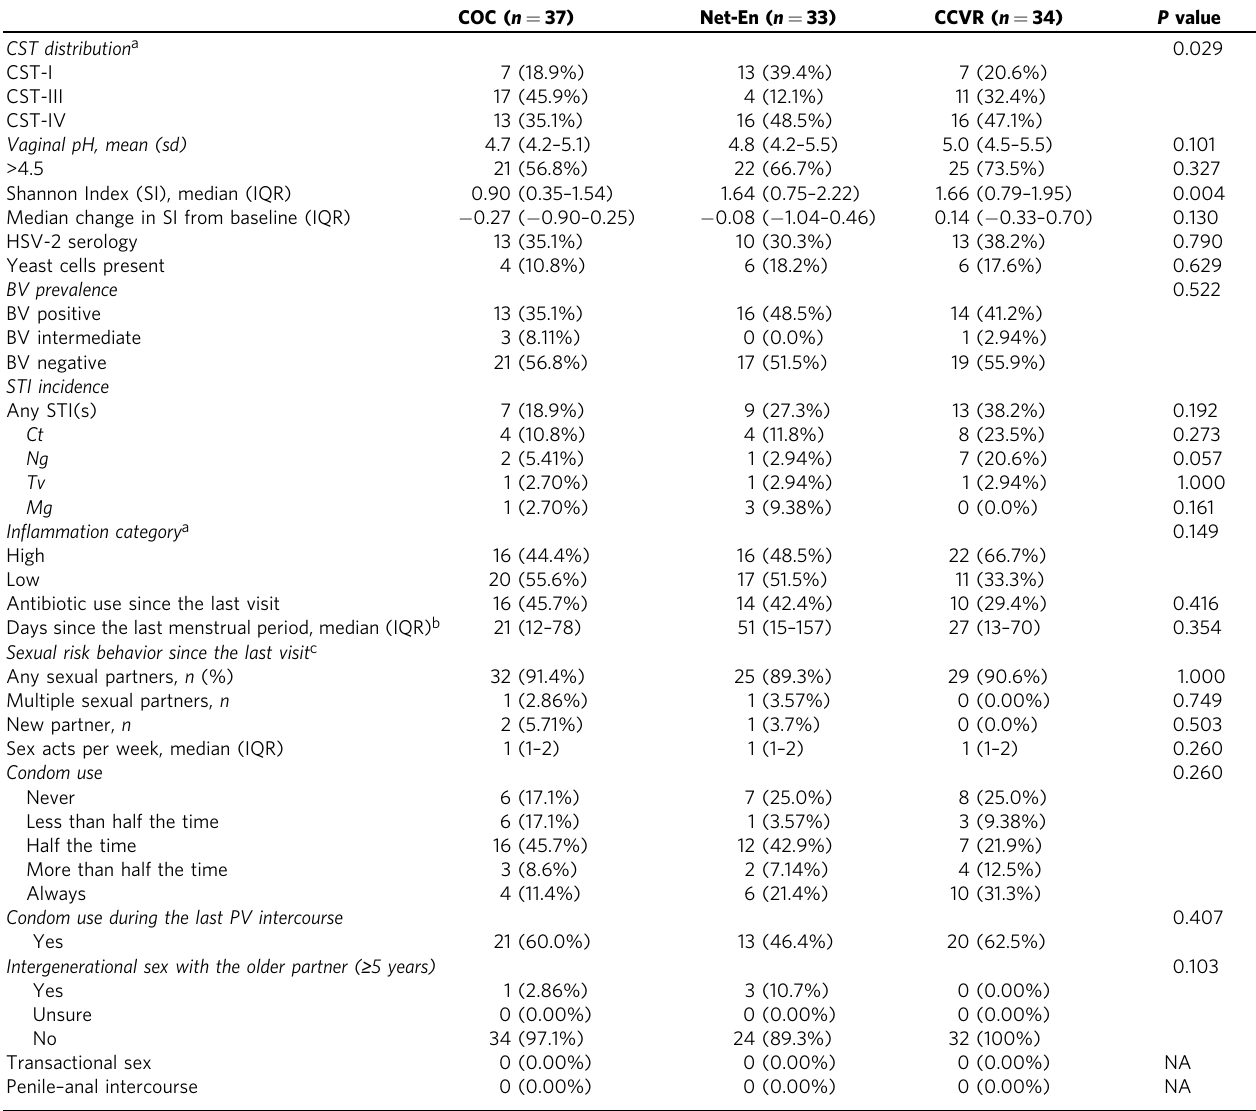
Table 2 Characteristics of participants with microbiome data at crossover according to assigned study arm (intention-to-treat). COC ( n =